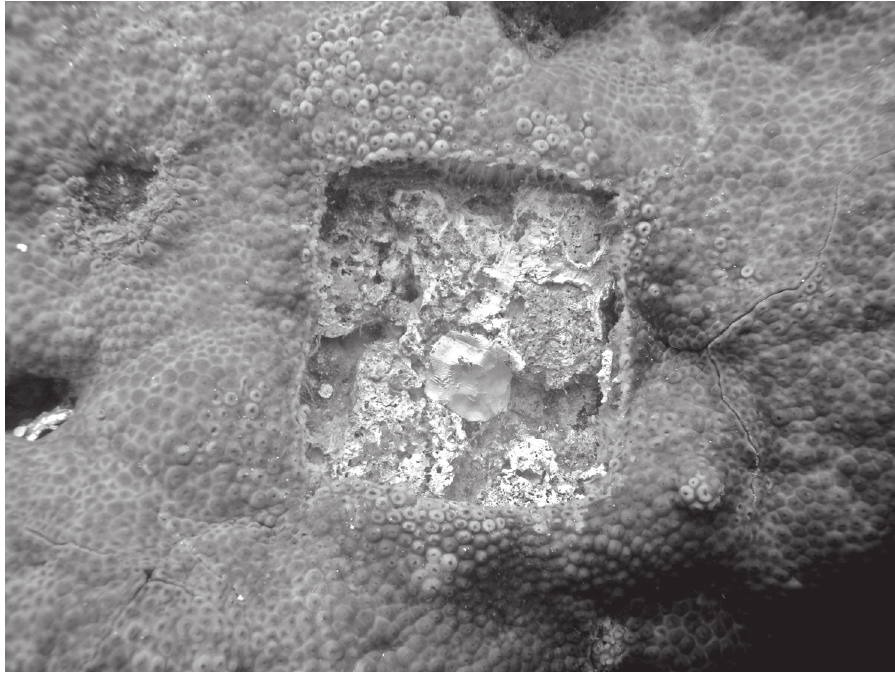
Figure 2 - Colony of Palythoa caribaeorum with an experimental area on the first day of experiment. The center of the square (100cm 2 ) formed by tissue removal was marked with underwater epoxy resin to facilitate its